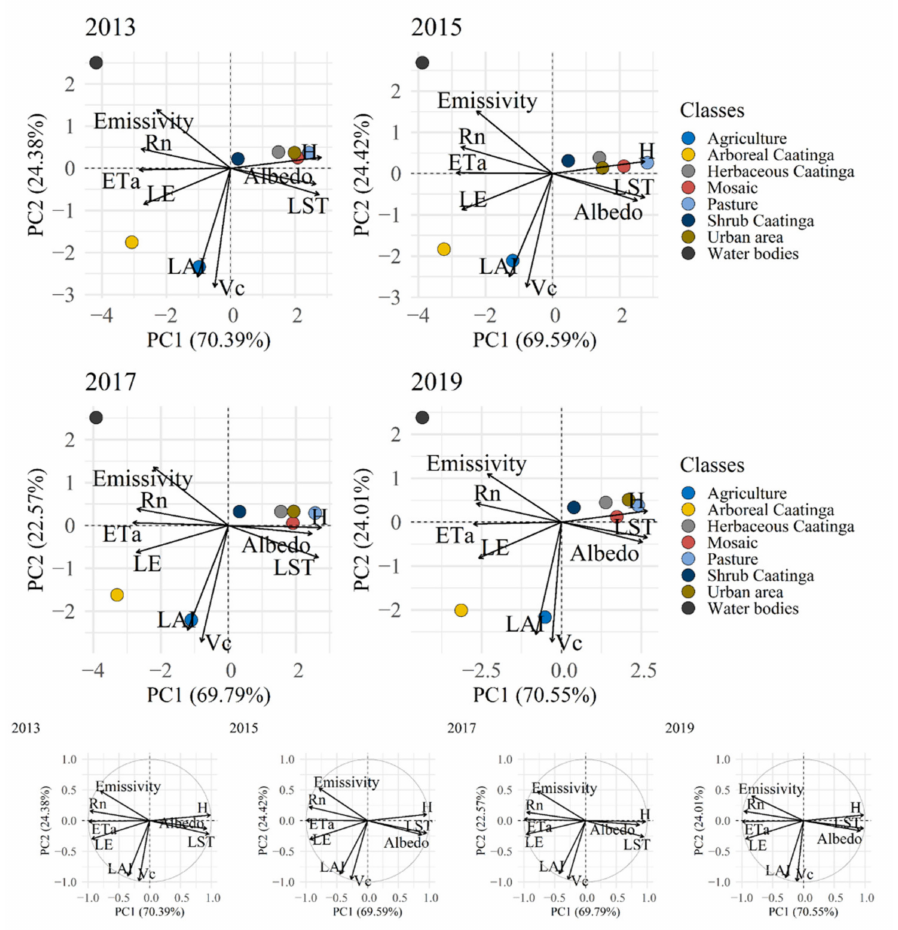
Figure 10. Scores obtained by principal component analysis (PCA) of environmental variables and land use and land cover. PC1 and PC2 are the first and second dimensions of PCA data, respectively. The four inserted panels below the PCA scores plots refer to the loadings plots of the first two principal components from 2013 to